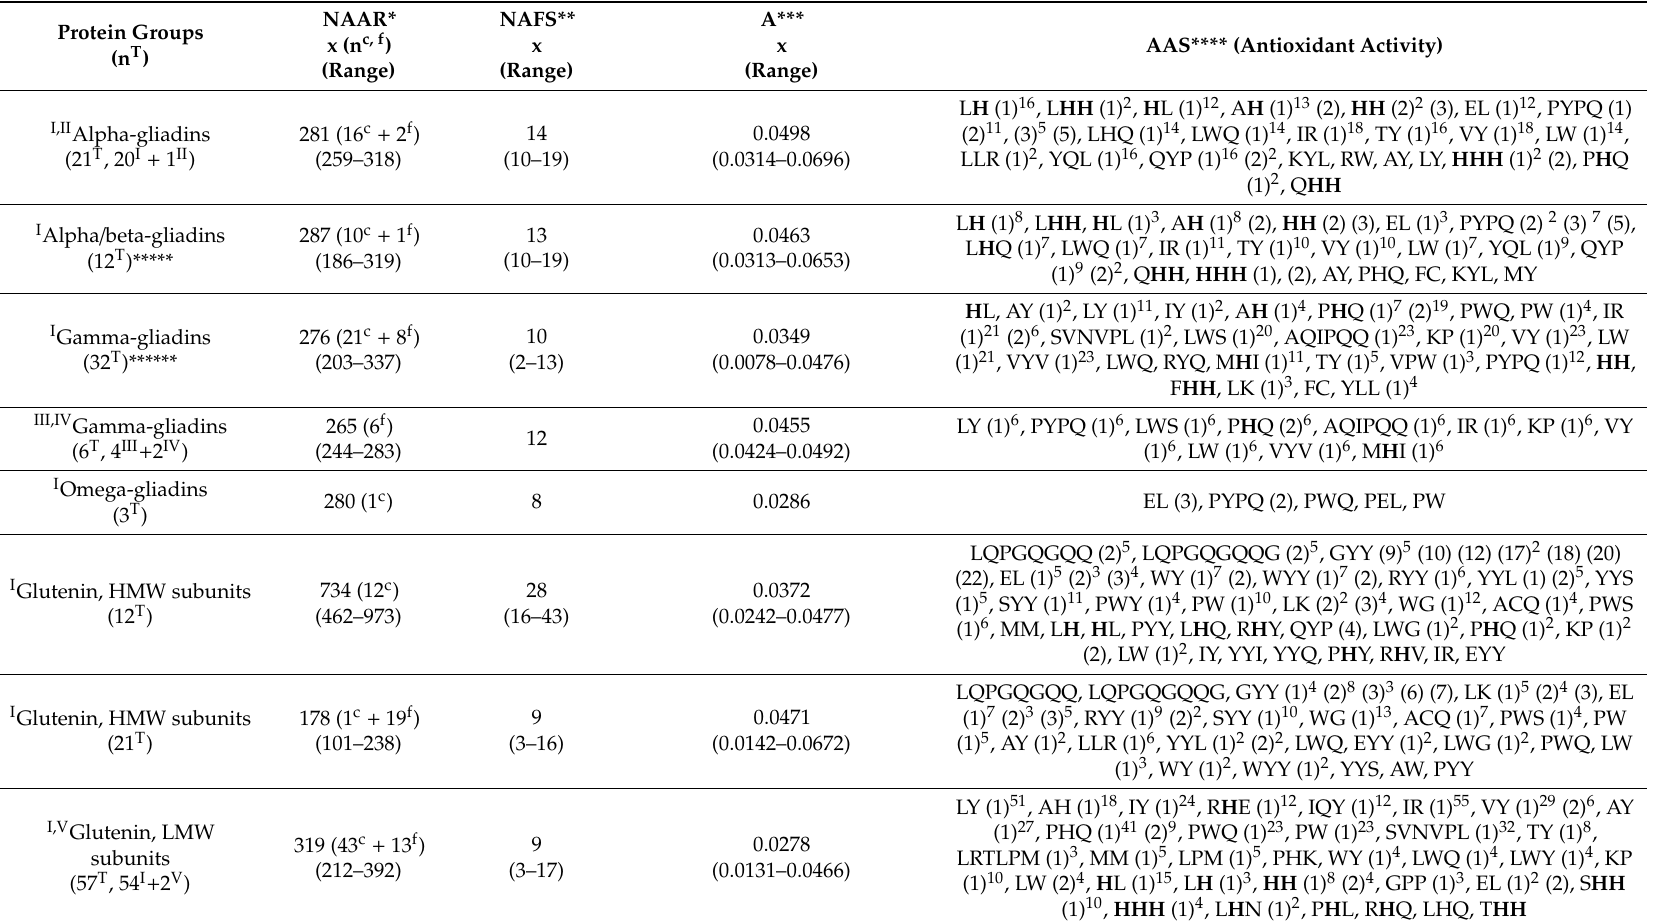
Table 1. Characteristics of wheat proteins antioxidant activity ( I Triticum aestivum, II Triticum aestivum subsp. Spelta, III Triticum aestivum spp.